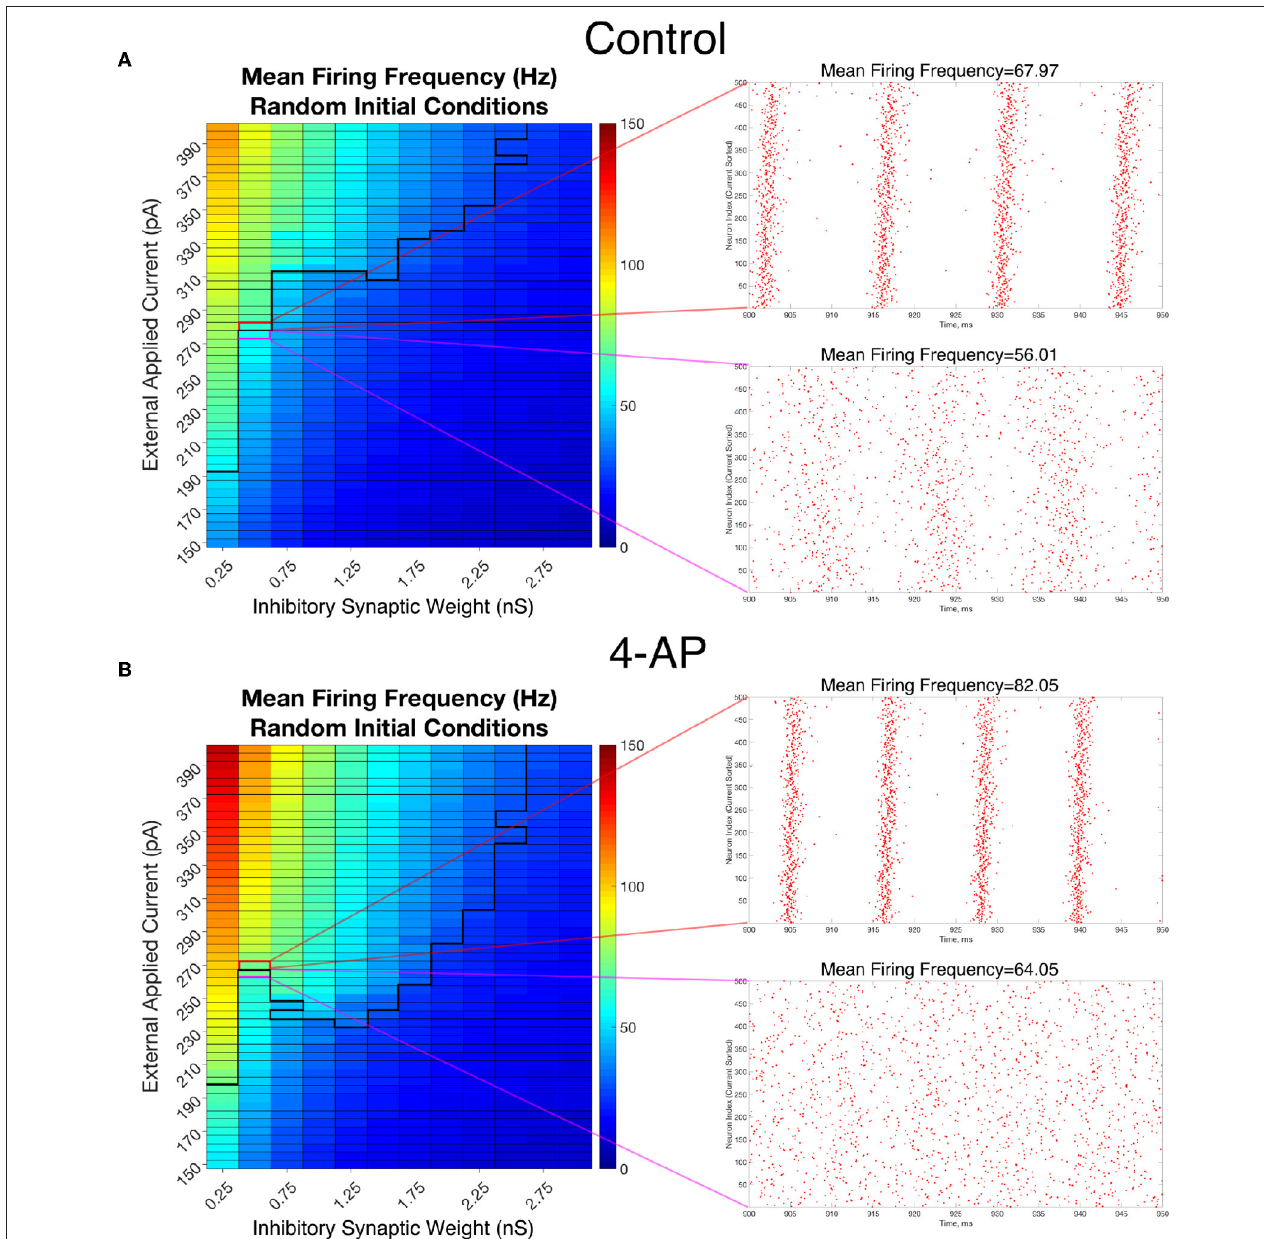
FIGURE 7 | Overall firing frequency is higher in networks exhibiting synchrony, relating the transition from asynchrony to synchrony to increased interneuronal activity. (A,B) Mean Firing Frequency values, averaged over five independent simulations, for control (A) and 4-AP (B) networks. The border dividing the parameter regime supporting synchronous dynamics (top-left) from the regime of asynchrony is depicted by the bolded black line, where this border was found using a cutoff value for the Synchrony Measure of 0.25 (which was found to be reasonable after a rigorous investigation of a variety of raster plots and their corresponding Synchrony Measures). Example raster plots for the networks outlined in pink and red illustrate example asynchronous and synchronous raster plots, respectively, along this border. Their Mean Firing Frequency values illustrate the relatively large increase in network activity that is associated with the transition from asynchronous to synchronous